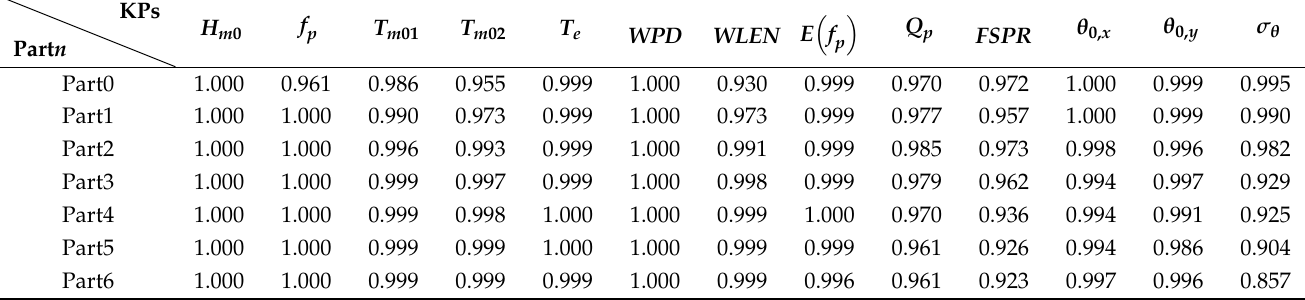
Table 3. Correlation coefficient (R) of the KPs derived from the original and the reconstructed spectra/partitions at check point B2. Sample numbers of Part0 to Part6 are 8760, 6407, 8729,